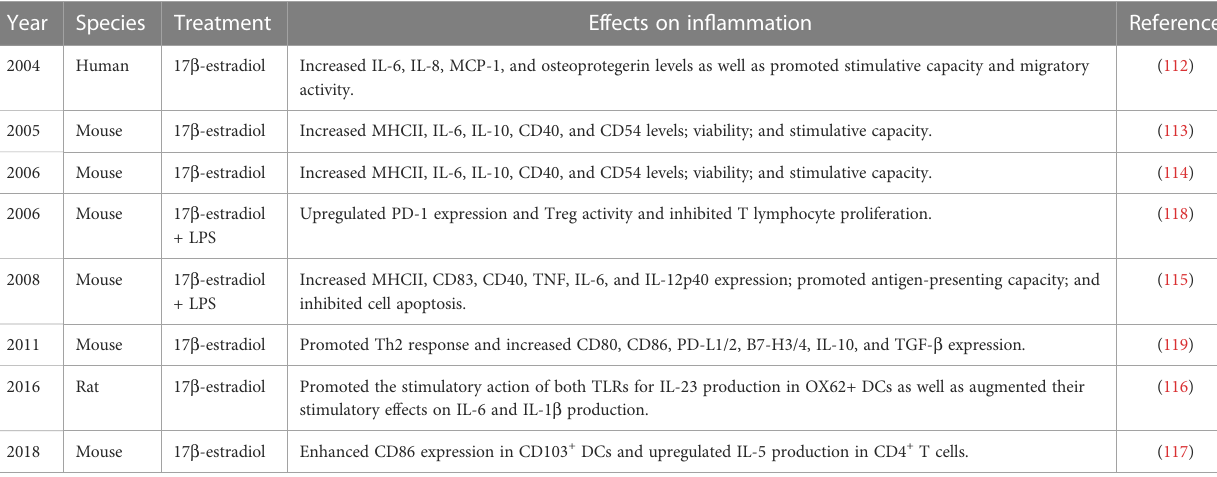
TABLE 5 Anti-in fl ammatory effects of estrogen on dendritic cells and adaptive